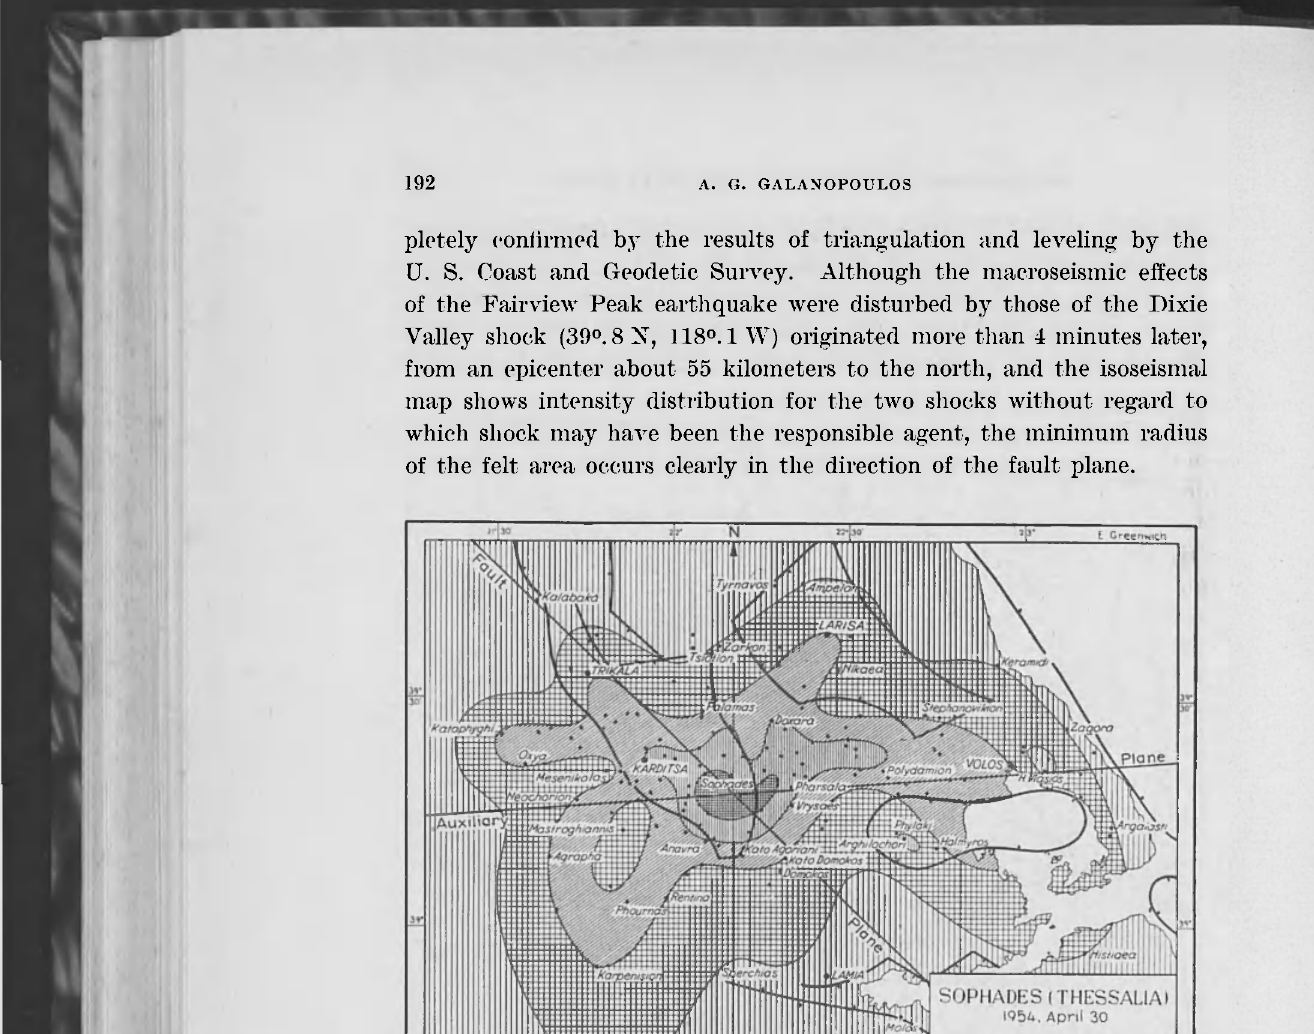
Fig. 3. - Intensity distribution in the area most strongly affected by the earthquake of Aprii 30, 1954, after A. Galanopoulos (1955) and the seismic solution obtained by J. Hodgson and J. Cock